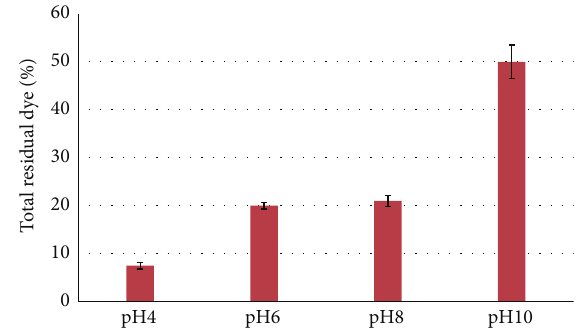
Figure 11: Percentage of residual dye after photodegradation at dif- ferent initial solution